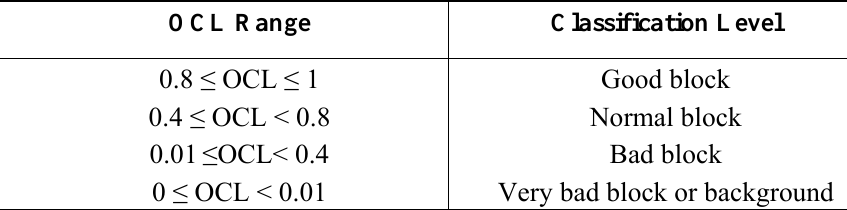
Table 2. Classification levels of the orientation certainty